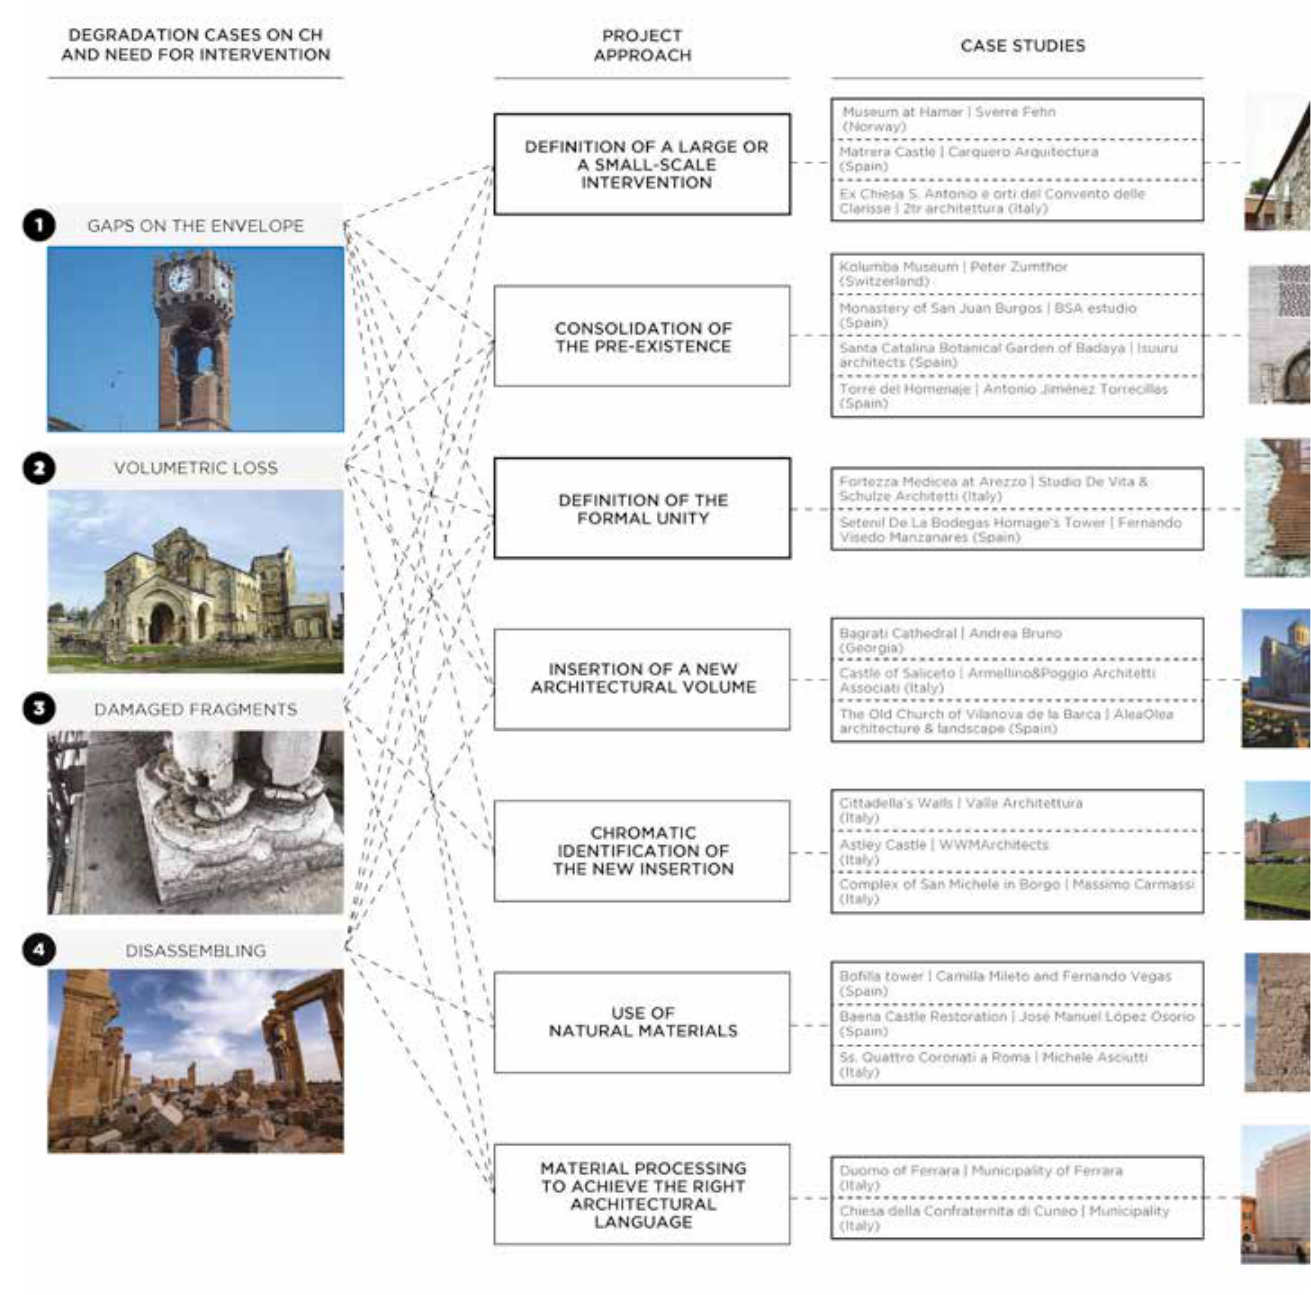
Figure 1: Cases of restoration of architectural heritage in the international framework. The selected projects are characterised by a similar design approach, using a contemporary language. Source: